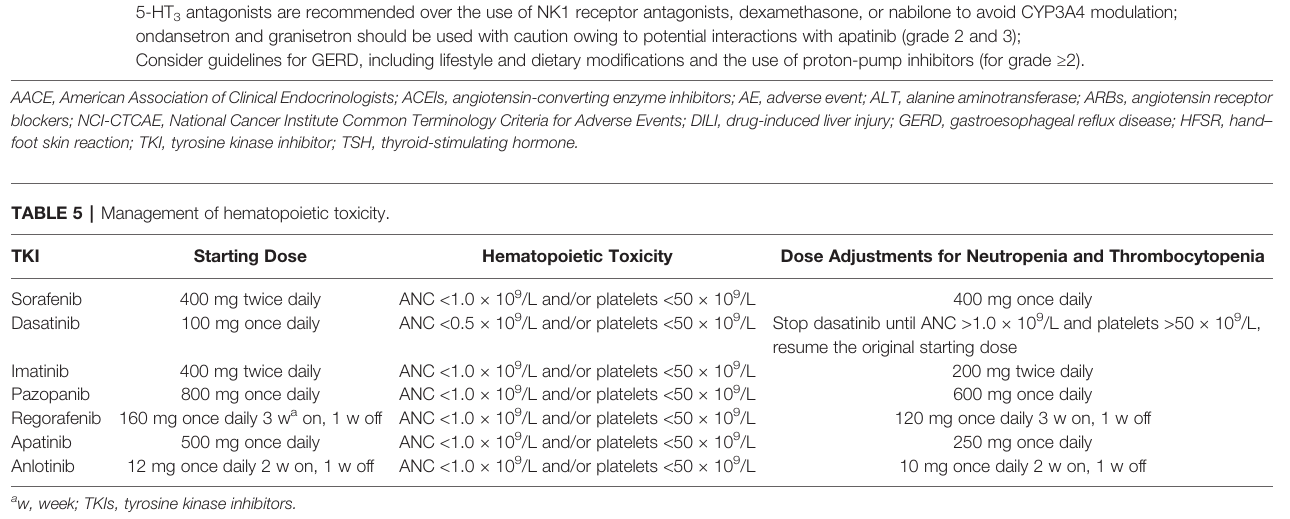
Supplementary Table 1 | PRISMA fl ow diagram.